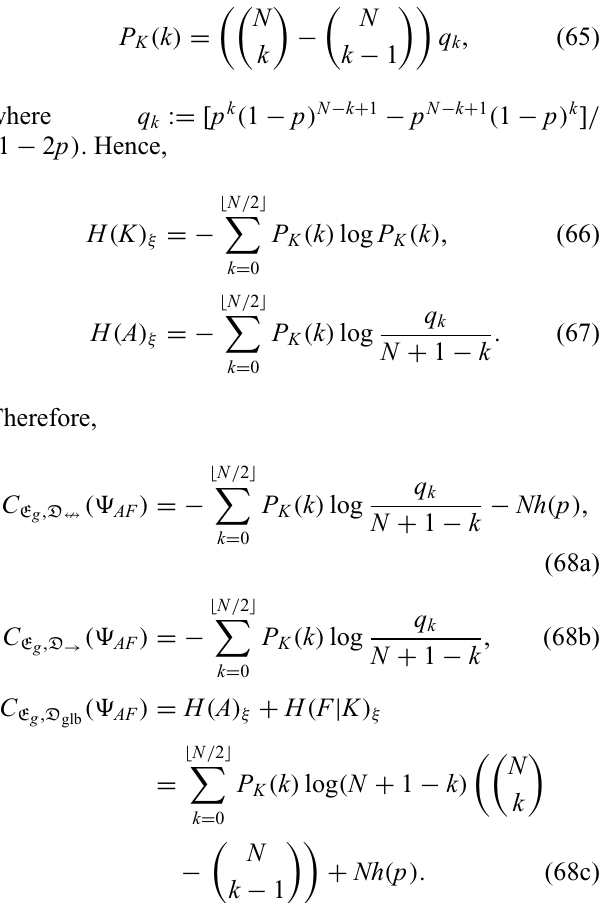
((cid:2) ) with AF g , D (cid:2)